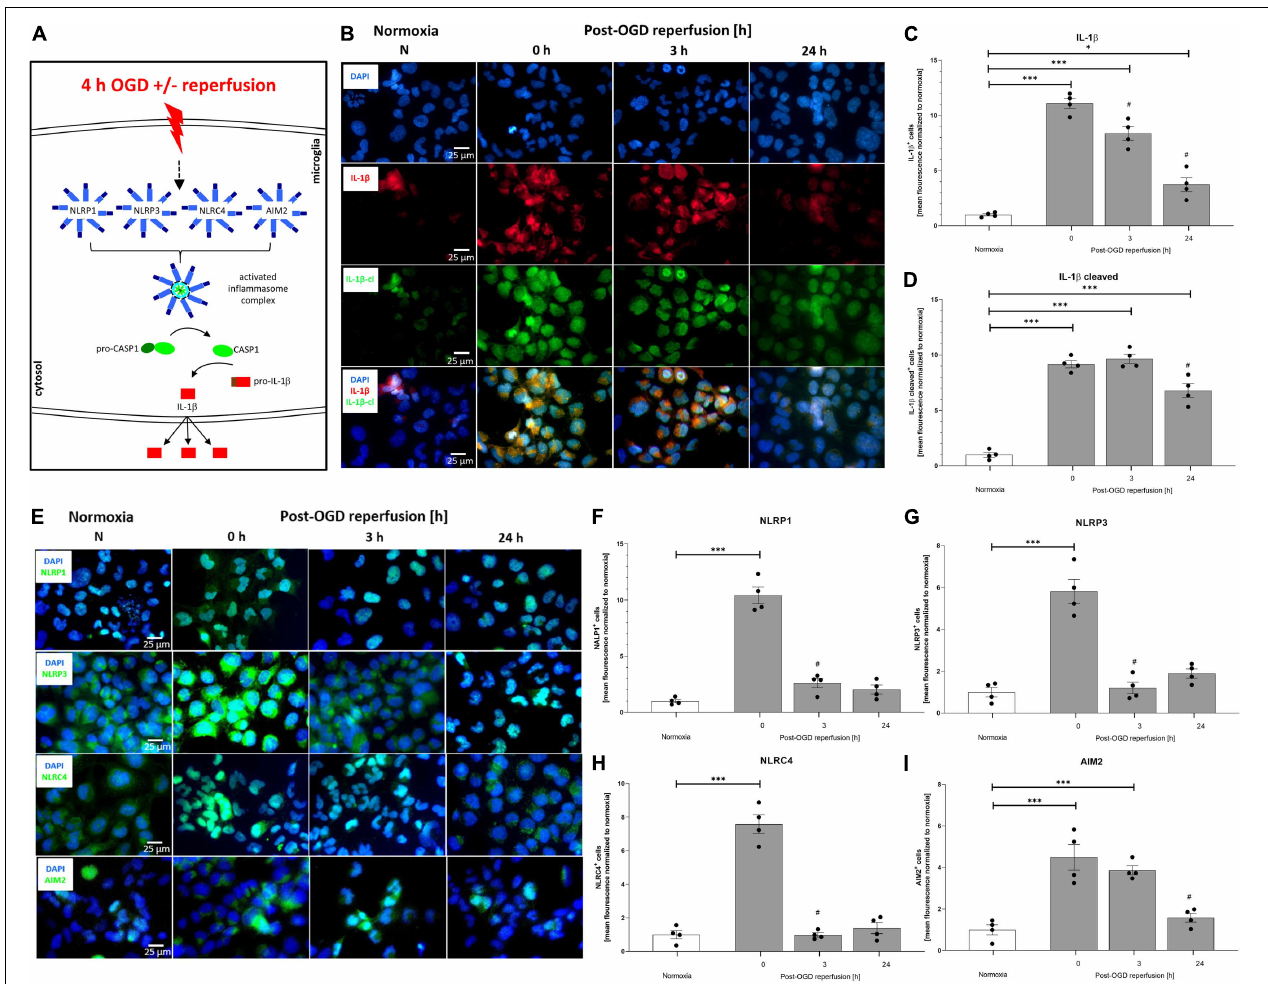
FIGURE 5 | Oxygen-glucose-deprivation-dependent upregulation of IL-1 β and the NLRP1, NLRP3, NLRC4, and AIM2 inflammasomes in human microglial cells. HMC-3 microglial cells were subjected to 4 h of OGD followed by a reperfusion period of up to 24 h. (A) Schematic illustration of the inflammasome cascade upon OGD. Representative immunocytochemistry of (B) DAPI (blue), IL-1 β (red), cleaved IL-1 β (green), and (E) NLRP1, NLRP3, NLRC4, and AIM2 (all inflammasomes green) from 3 independent experiments. Mean fluorescence intensity per 1,000 cells of (C) IL-1 β , (D) cleaved IL-1 β and (F) NLRP1, (G) NLRP3, (H) NLRC4, and (I) AIM2. Intergroup differences were tested by ANOVA two-way followed by Tukey post hoc test (multiple comparison). Bars represent means ± SD of 3 individual experiments with 3 technical replicates, individual data points are shown. ∗ p < 0.05, ∗∗ p < 0.01, ∗∗∗ p < 0.001 between groups, # p < 0.05 compared to previous reperfusion